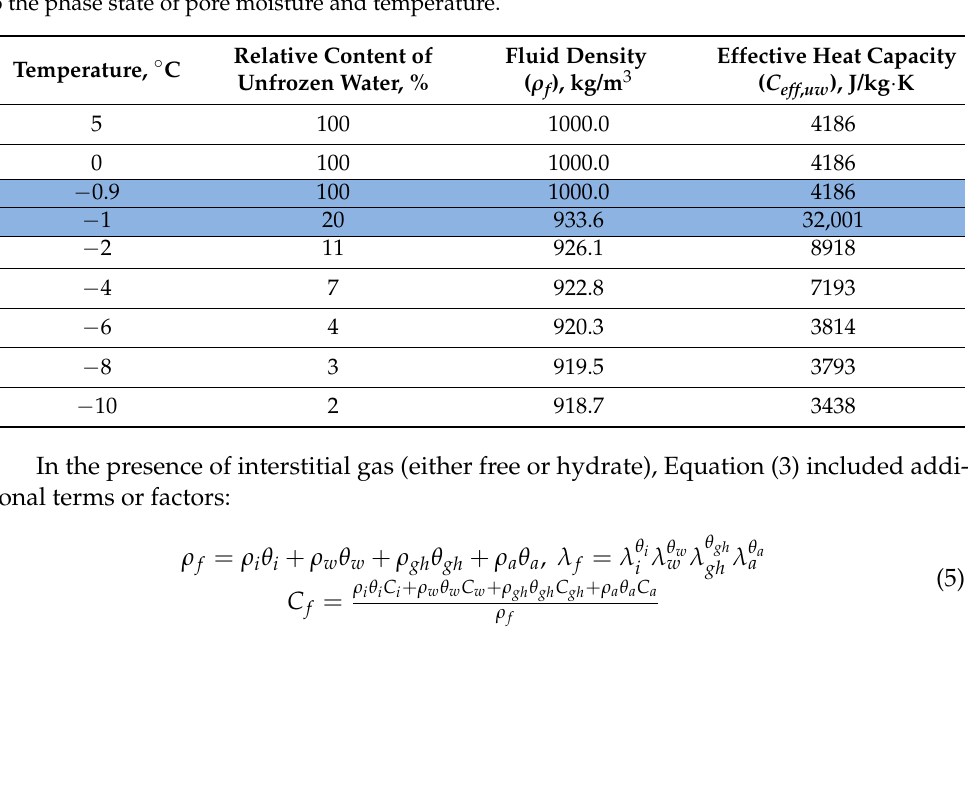
Table 3. Thermal properties of lean clay (depth interval 60–120 m) free from gas hydrates, with regard to the phase state of pore moisture and